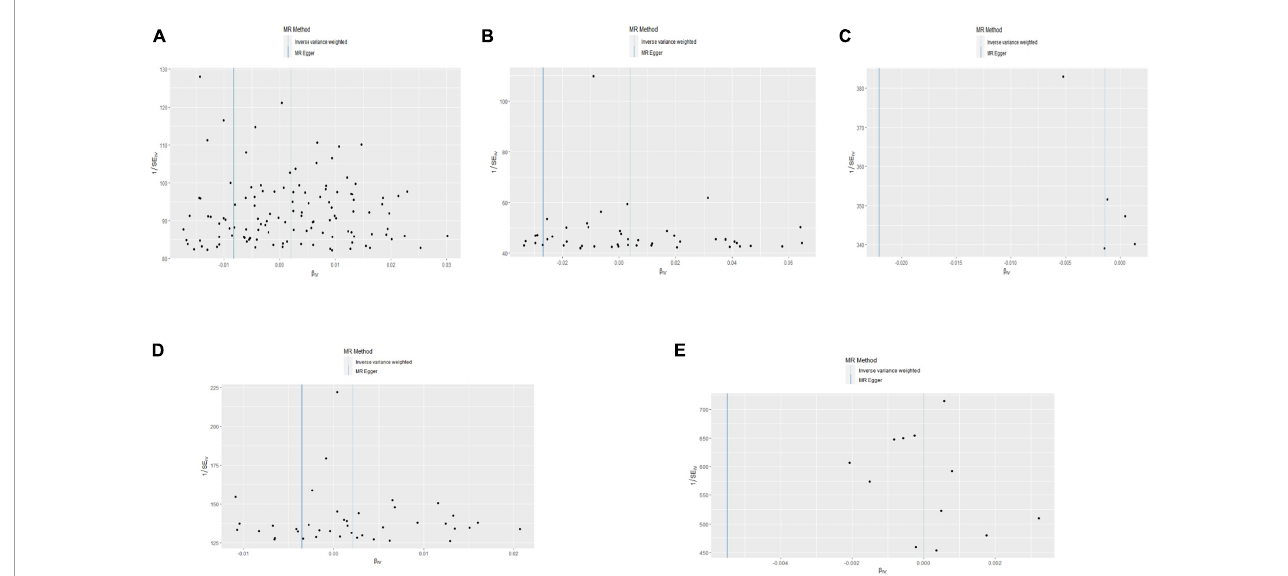
FIGURE5 Funnel plot of the causal effects of body mass index (BMI), ever smoking, heart failure, alcohol intake frequency, and inflammatory bowel disease (IBD)-related single nucleotide polymorphism (SNPs) on pulmonary embolism (PE). The Mendelian randomization (MR) estimated effect sizes for BMI (A) ,